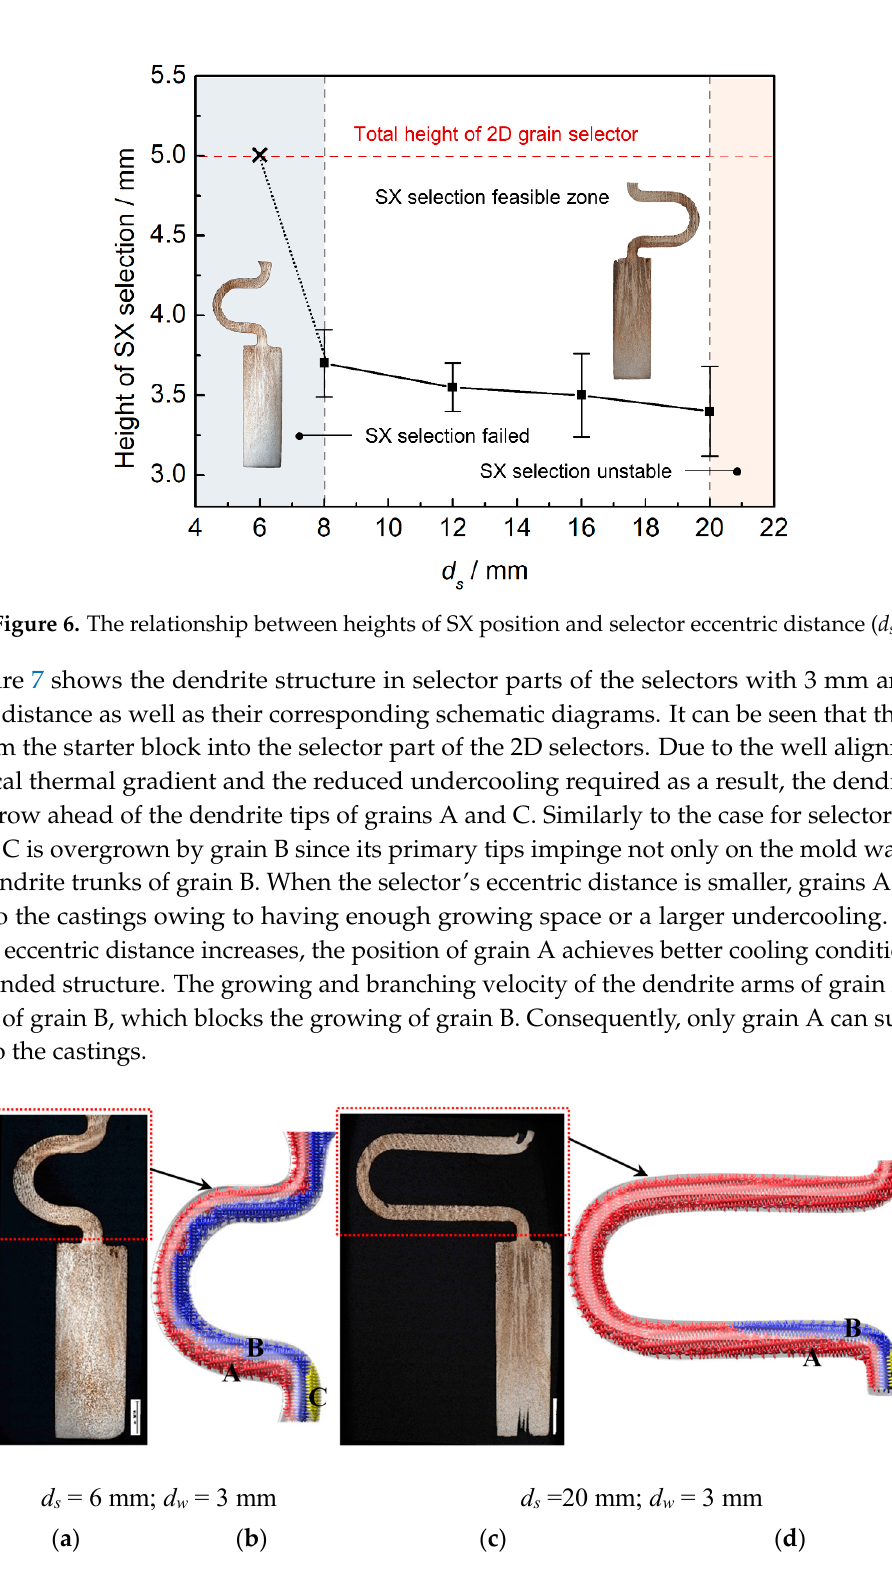
Figure 7. Optical images of the dendrite structure in the selector parts of the selectors with 3 mm ( a ) and 20 mm ( c ) eccentric distance as well as their corresponding schematic diagrams ( b ) and ( d ).